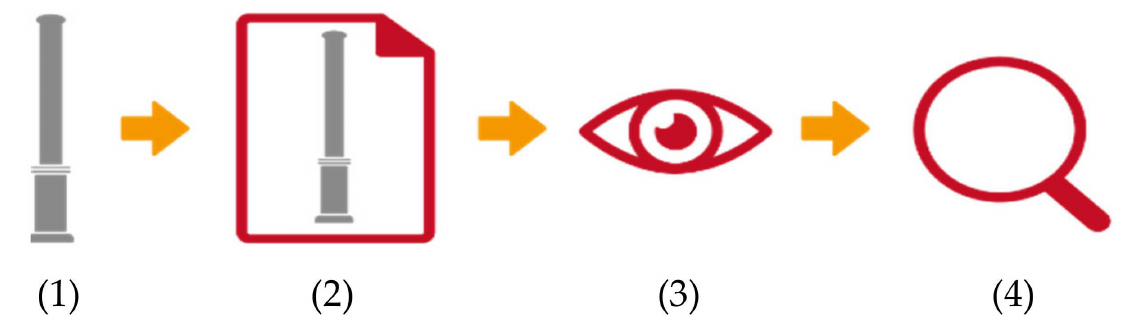
Figure 5. The analogue research process: A historical column (1) is either directly receivable or documented with sources (2), which is perceived by the researcher (3) to investigate a specific research question